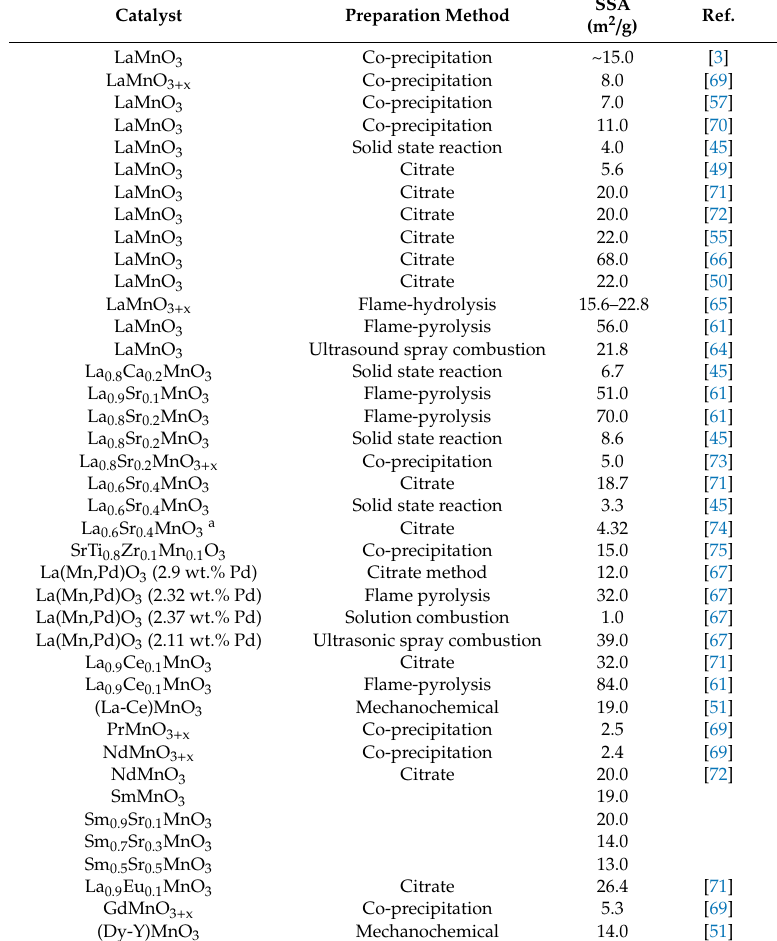
Table 3. The influence of the synthesis method on the specific surface area of di ff erent lanthanide manganate-based perovskite